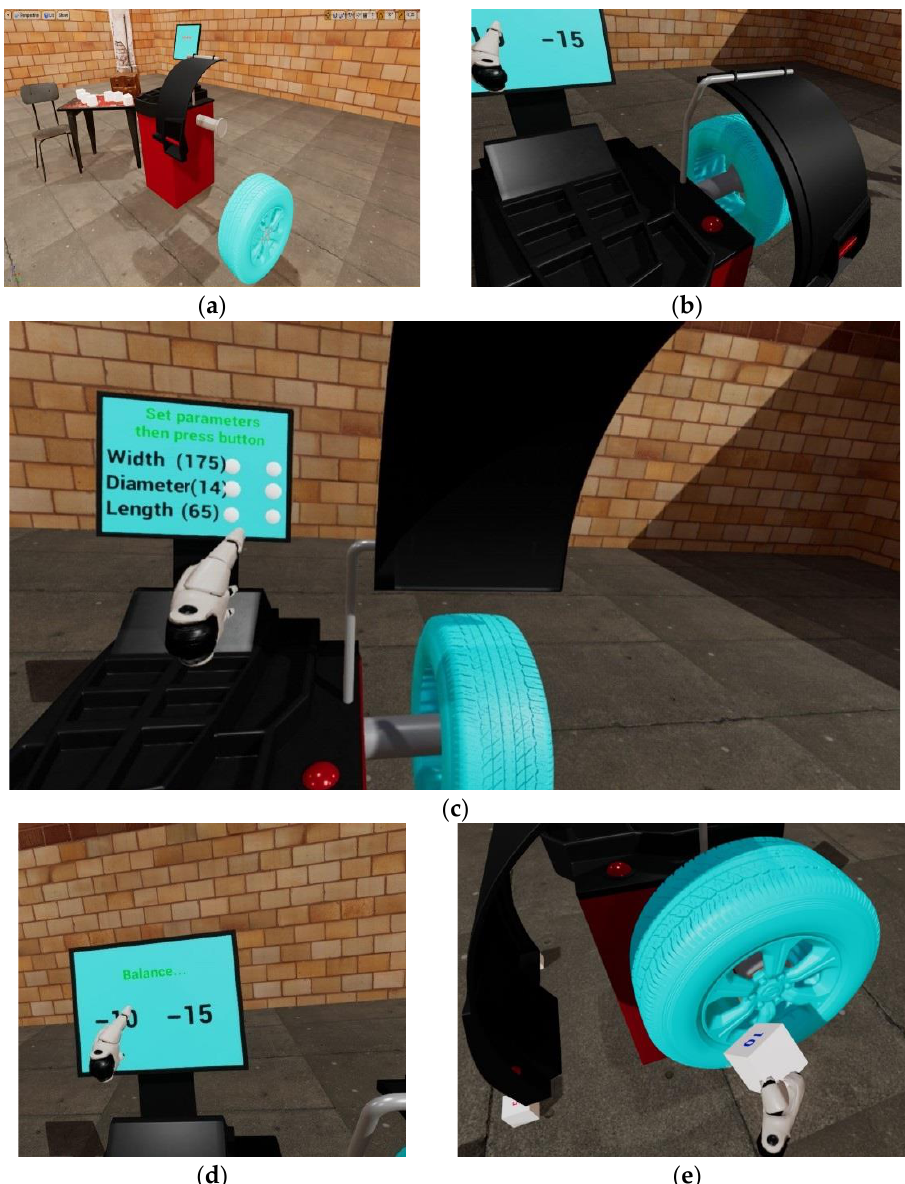
Figure 4. View of virtual laboratory: ( a ) before the wheel is installed on the balancing bench; ( b ) after installation; ( c ) wheel settings; ( d ) wheel needs balancing: 10 grams on the left and fifteen on the right; ( e ) installing weight on the right